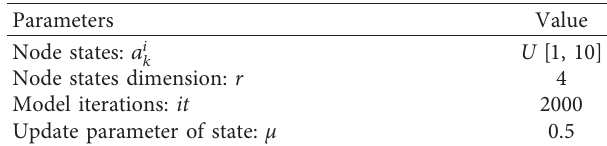
Table 3: The initial parameters of the